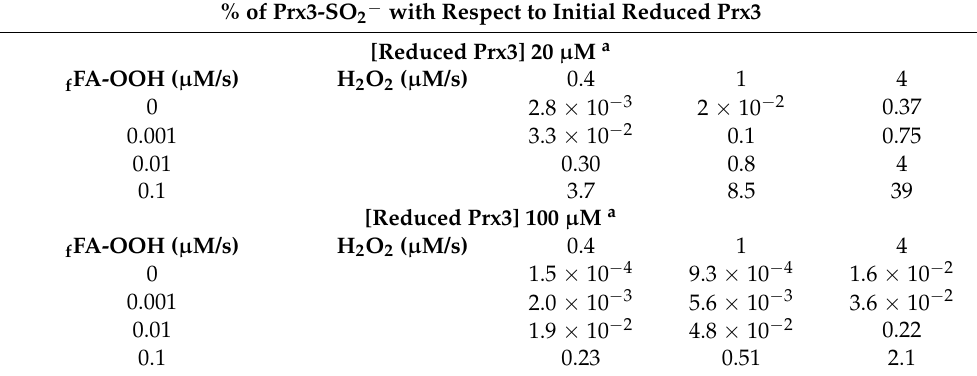
Table 5. Expected percentages of hyperoxidated Hs Prx3 in mitochondria forming different fluxes of H 2 O 2 and f